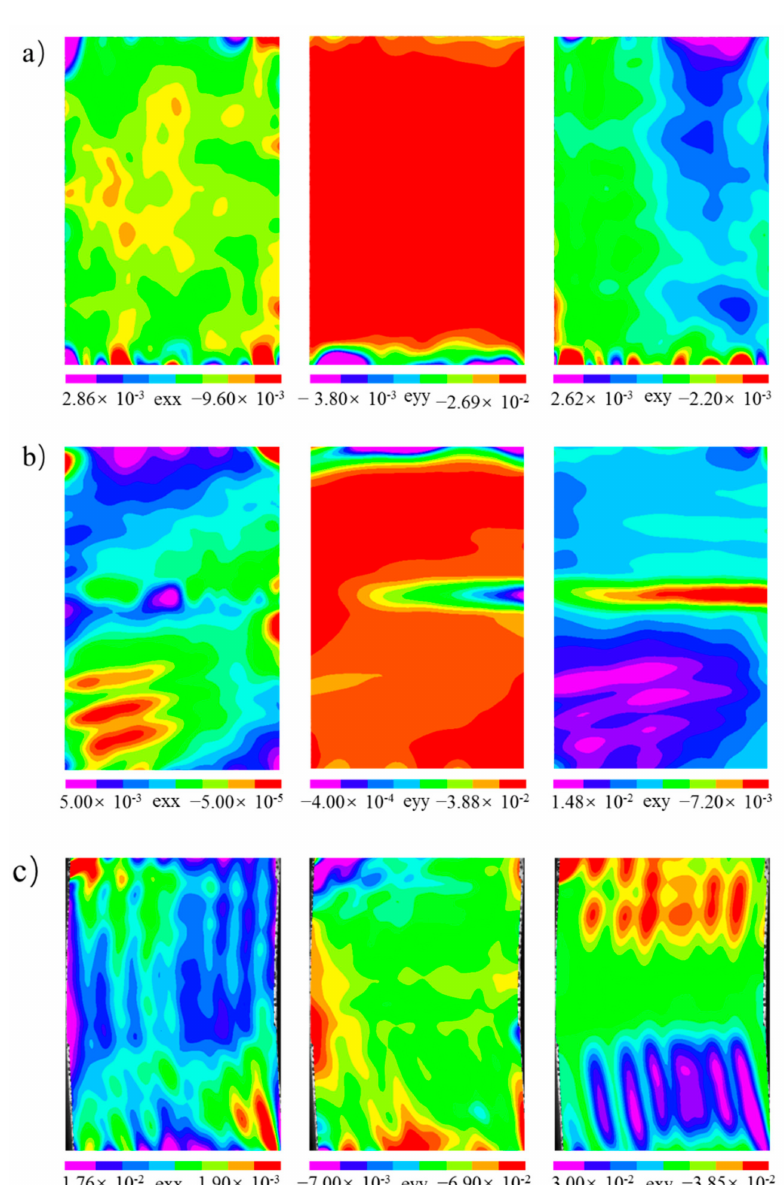
Figure 9. The distribution of the strain field in the yield stage: ( a ) longitudinal direction ( F = 25.73 kN); ( b ) radial direction ( F = 2.33 kN); ( c ) tangential direction ( F = 4.10